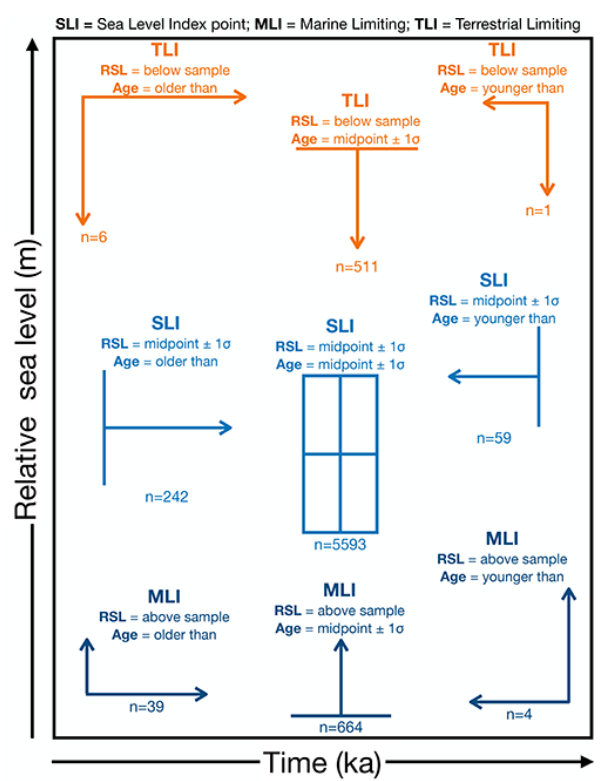
Figure 7. Nine possible combinations of sea-level proxies and age determination types in WALIS 1.0. The number on the bottom of each type indicates its frequency within the database.